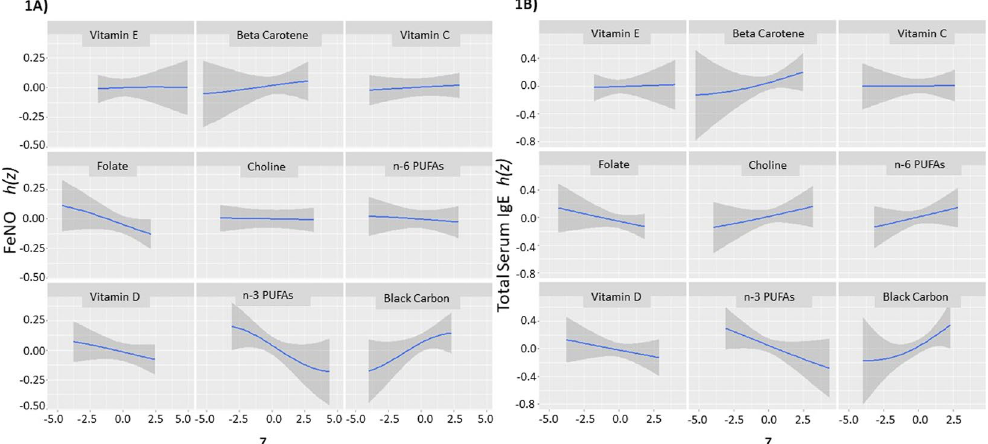
Figure 1. Estimated exposure response functions ( h (z)) for prenatal nutrient intake (foods only), prenatal air pollution (Black carbon) and allergic disease outcomes in adolescence. Plots show the estimated relationship between log-transformed z scores of exposures (z) and outcomes; shaded areas indicate 95% credible intervals. Plots are shown for outcomes FeNO ( A ) and Total Serum IgE ( B ).